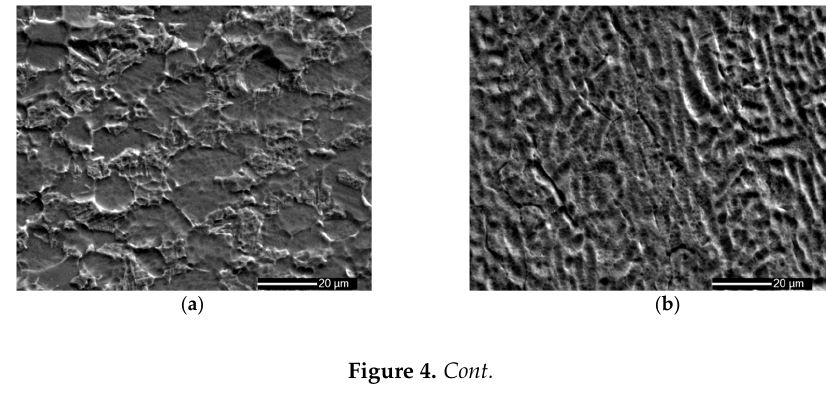
Figure 3. Cross section of the linear friction welding (LFW) joints with Ti64 and Ti17alloys.